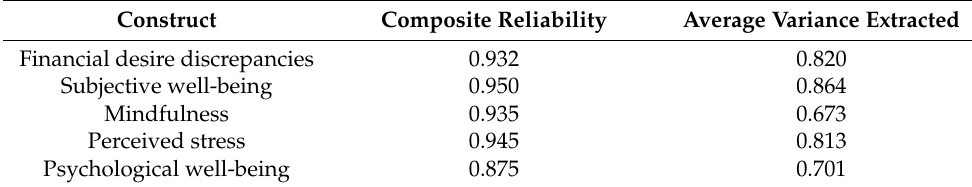
Table 6. Composite Reliability and Average Variance